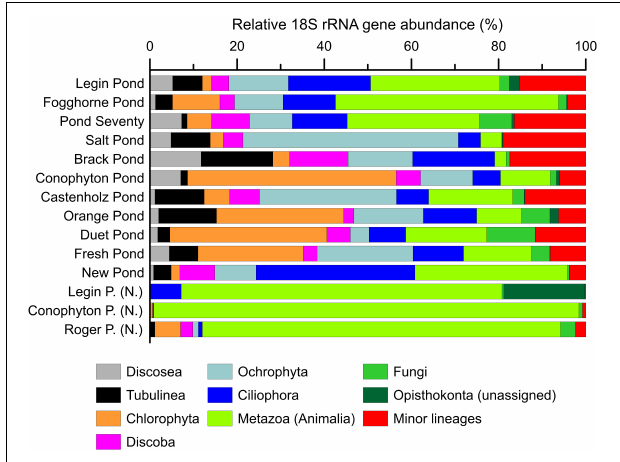
FIGURE 4 | The relative abundance (%) of eukaryotic 18S rRNA genes in microbial mat communities. Shown are the major eukaryotic phyla. Detailed results from the 18S rRNA sequencing can be found in the supporting information. Samples with (N.) indicate ‘Nostoc spheres,’ which were collected in three different meltwater